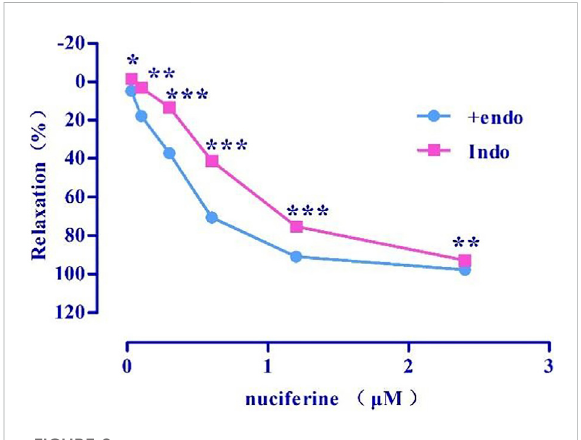
Effect of Indo on nuciferine induced vasorelaxation. The data are expressed as the means ± SD of 6 – 8 rats ( n = 6 – 8). (* p < 0.05, ** p < 0.01 and *** p < 0.001 vs. control group).